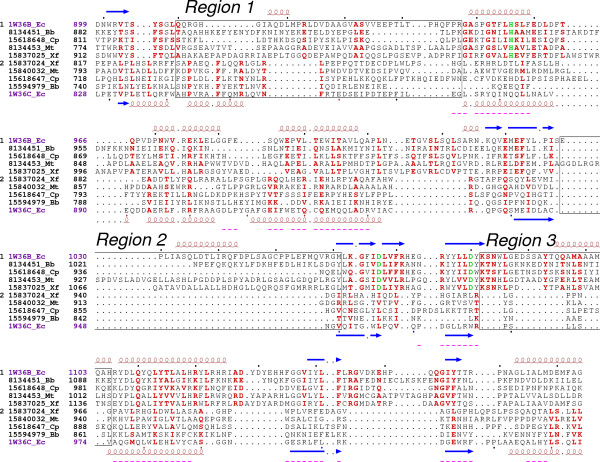
Structure-based sequence alignment of the nuclease(-like) domains of RecB and RecC. Nuclease(-like) domain sequences of RecB (above, group 1) and RecC (below, group 2) were chosen from diverse representative species and extracted from complete alignments of COG database [31] entries for RecB or RecC. Purple indicates the E. coli sequences crystallized as the RecBCD complex (PDB code 1w36; [18]). Other sequences are labelled with Genbank numbers and sequence codes Bb, Borrelia burgdorferi; Cp, Chlamydophila pneumoniae; Mt, Mycobacterium tuberculosis; Xf, Xylella fastidiosa. Red colouring indicates conservation within each group while green is used for three important catalytic residues of RecB – H956, D1067 and D1080 [18]. Elements of regular secondary structure are shown above (RecB) and below (RecC) the alignment, where spirals represent α-helices and arrows β-strands. The three key regions (numbered 1–3) involved in adaptation of the RecC nuclease-like domain to its new function, as discussed in the text (see also Fig 2), are boxed and labelled. Purple underlining indicates zones that can be simultaneously structurally aligned (rms deviation of 2.19Å for 71 Cα atoms).